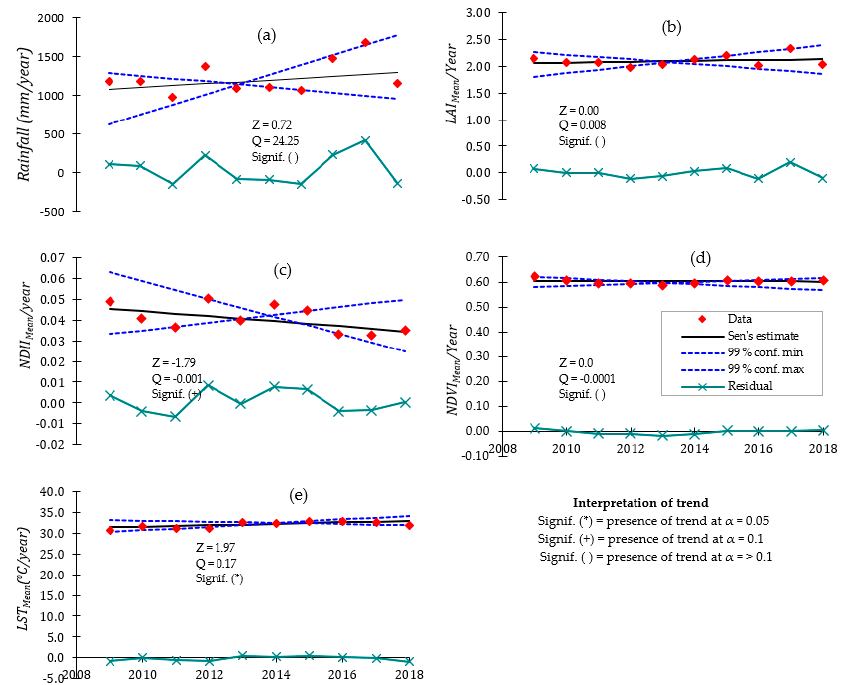
Figure 8. Mann–Kendall trends test and the Sens’ slope estimates for mean annual rainfall ( a ), mean annual LAI Mean ( b ), mean annual NDII Mean ( c ), mean annual NDVI Mean ( d ), and mean annual LST Mean ( e ) for the period of 2009 to 2018. Years with relatively high LST values seem to correspond to years with relatively low rainfall and NDII values.